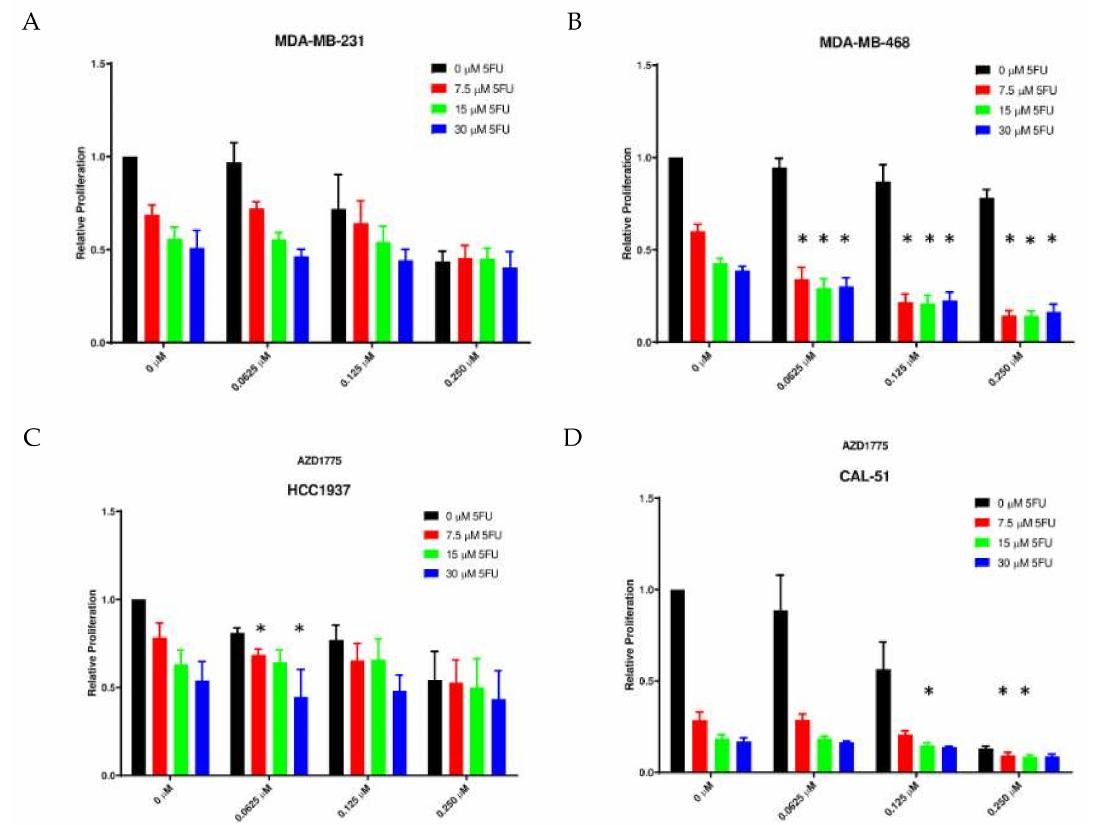
Figure 4. Cytotoxic e ff ects of AZD1775 and 5FU in TNBC cell lines. Cells were treated with AZD1775 and 5FU and cytotoxic e ff ects were assessed at 72 h using the sulforhodamine B (SRB) assay. Synergistic e ff ects were analyzed using Calcusyn software. ( A ) MDA-MB-231, ( B ) MDA-MB-468, ( C ) HCC1937, and ( D ) CAL-51. (* = CI <